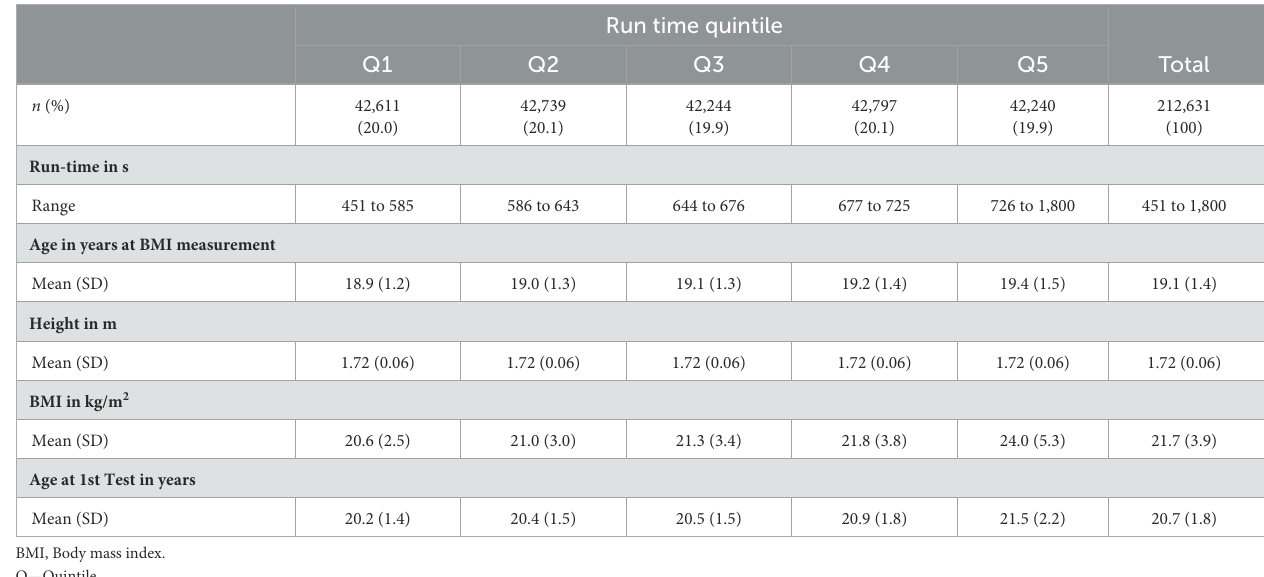
TABLE 1 Characteristics of the participants by run-time quintile ( n = 212,631).